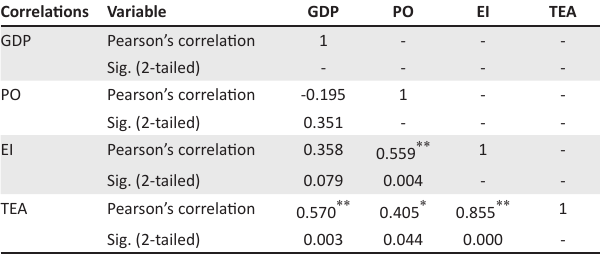
TABLE 2: Correlation between gross domestic product and total early-stage entrepreneurial activity (TEA), and TEA with perceived opportunity and entrepreneurial intentions in efficiency-based